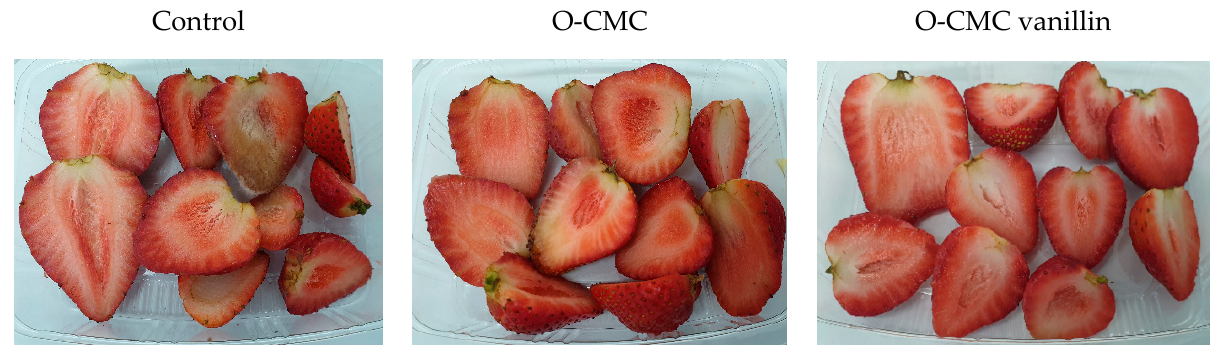
Figure 4. (Left to right) untreated fresh-cut strawberries (control); treated with O-CMC and O-CMC vanillin formulations after 7 days of storage at 4 °C.